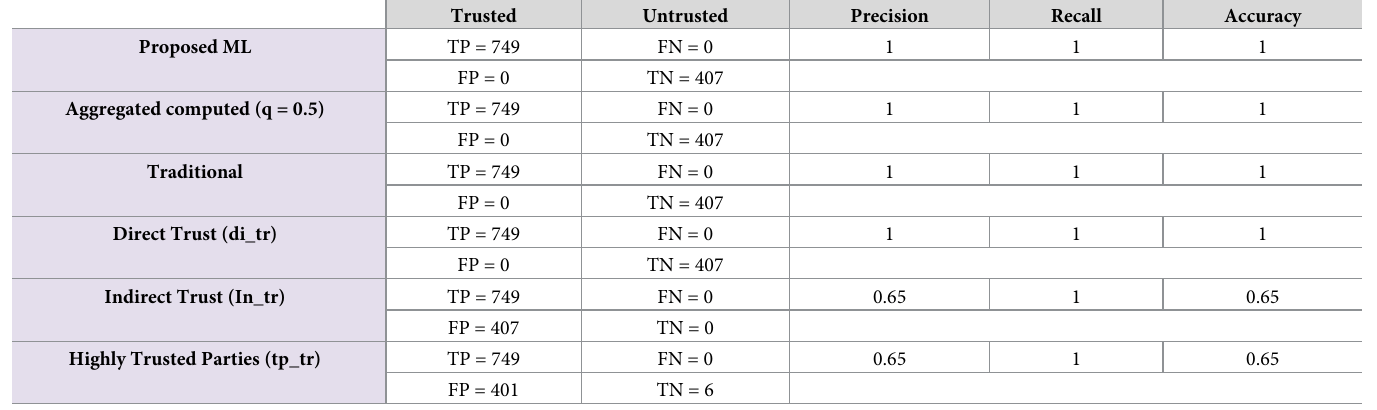
Table 1. Confusion matrix of the proposed models compared to the traditional method. Trusted Precision